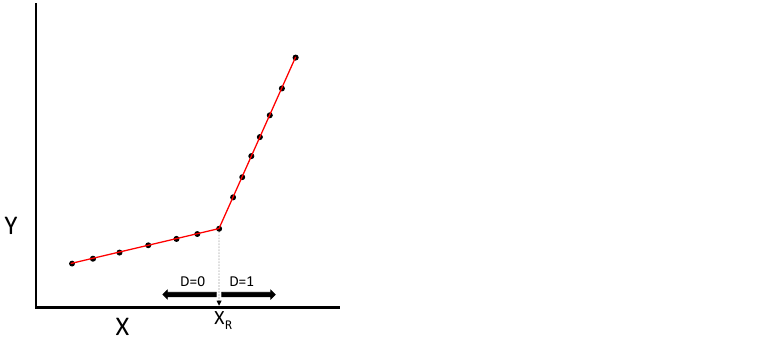
Figure 2. Representation of theoretical slope change (SPLINE), the data have been simulated.